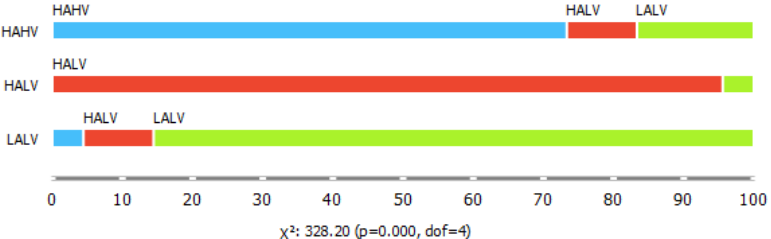
Figure 6. Recognition correspondence for each class and false positives, coefficients parameters: